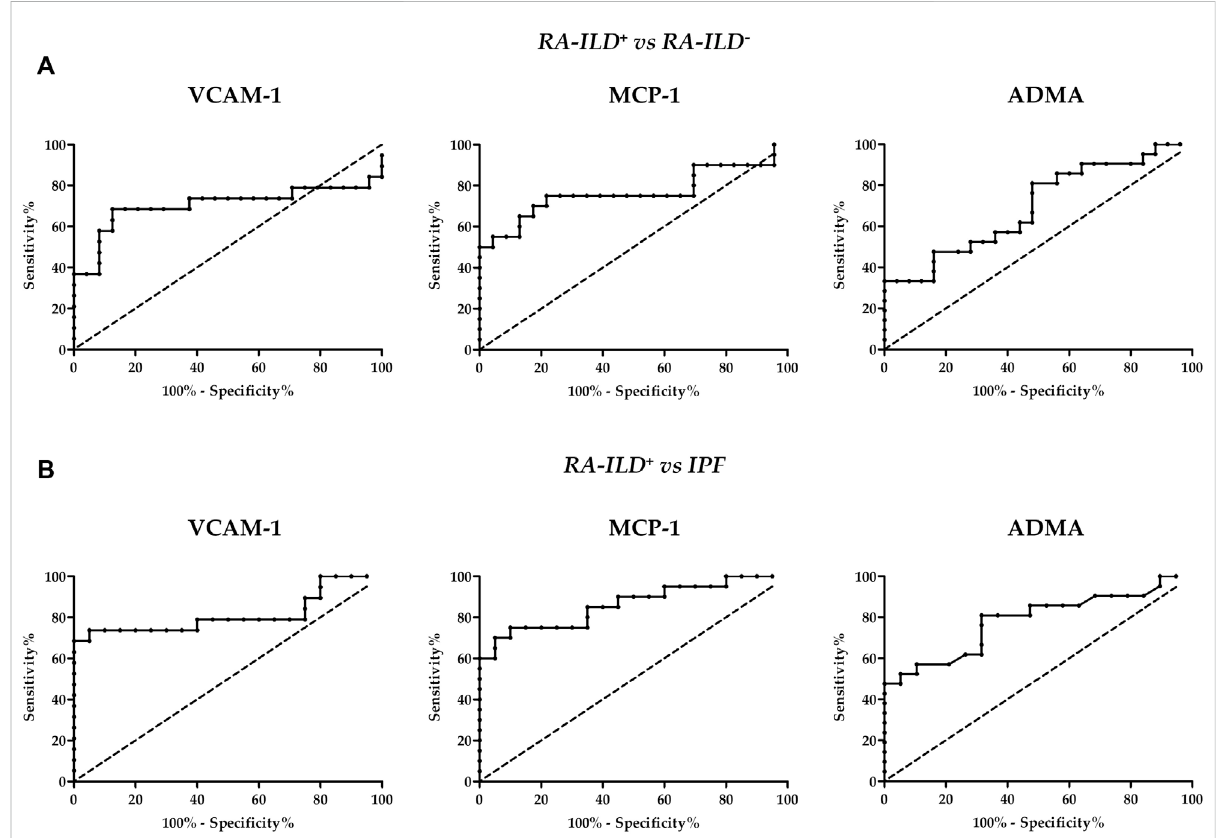
FIGURE 2 ROC curves of VCAM-1, MCP-1 and ADMA for the screening of RA-ILD + and RA-ILD − (A) and RA-ILD + and IPF (B) . RA, rheumatoid arthritis; ILD, interstitiallungdisease;IPF,idiopathicpulmonary fi brosis;VCAM-1,vascularcelladhesionmolecule1;MCP-1,monocytechemoattractantprotein-1; ADMA, asymmetric dimethylarginine.